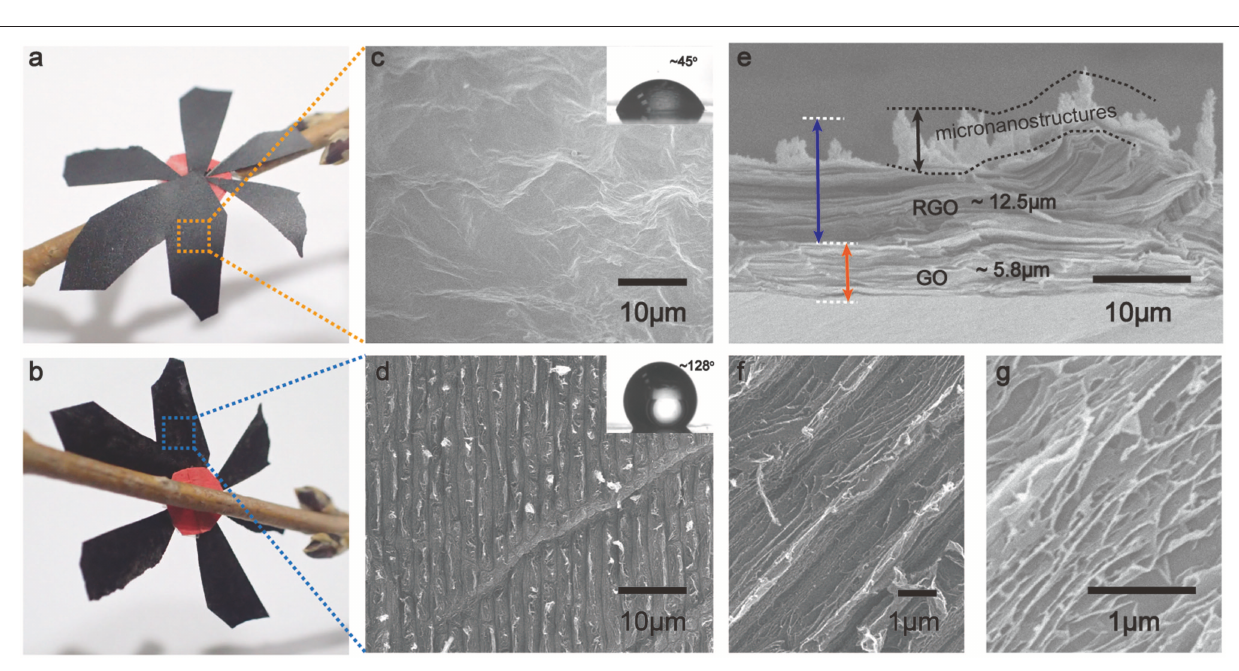
FIGURE 2 | (A,B) Photographs of the resultant GO/RGO bilayer structure viewed from the front side (A) and the reverse side (B) , respectively. (C–G) SEM images of GO/RGO bilayer structure. (C,D) SEM images of GO side and RGO side. The insets show water droplet contact angles of both sides. (E) SEM image of the sectional view of GO/RGO bilayer structure. (F,G) High-resolution SEM images of RGO